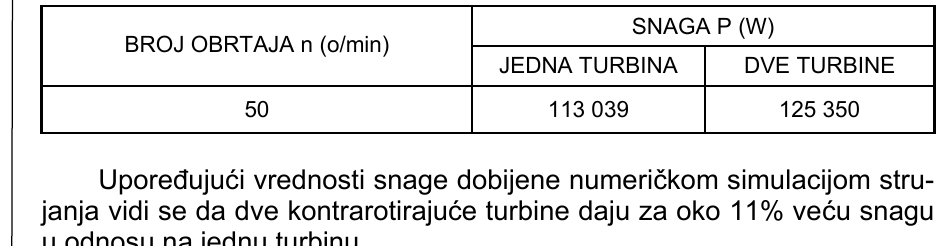
janja vidi se da dve kontrarotiraju ć e turbine daju za oko 11% ve ć u snagu u odnosu na jednu turbinu. Zaklju č